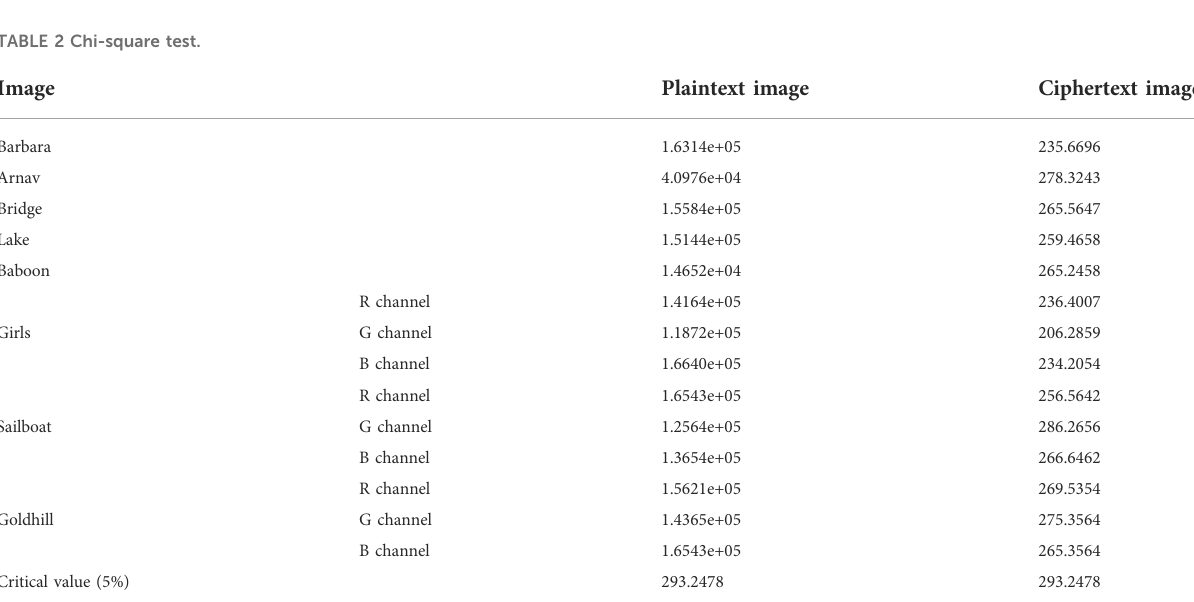
TABLE 2 Chi-square